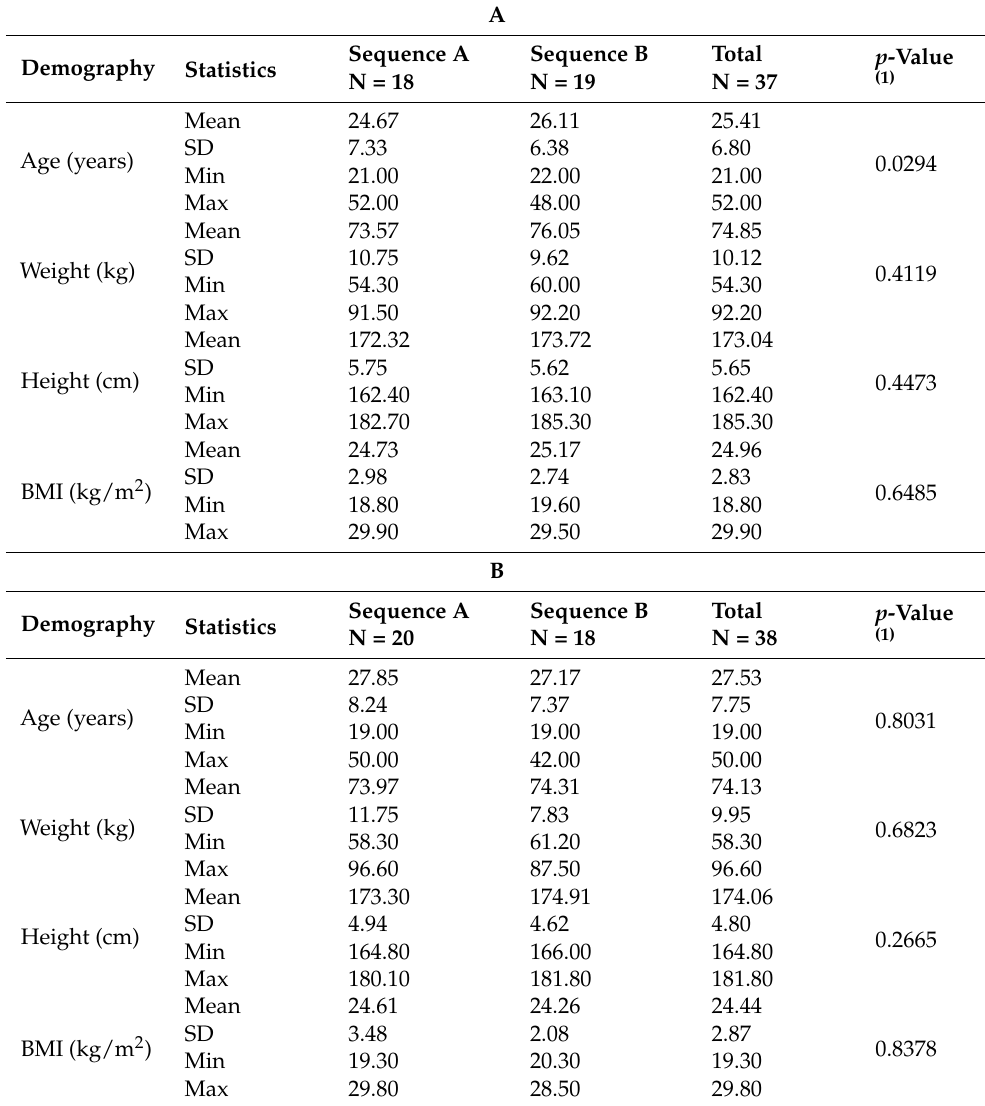
Table 2. (A) Demographic characteristics in Study I. (B) Demographic characteristics in Study II.